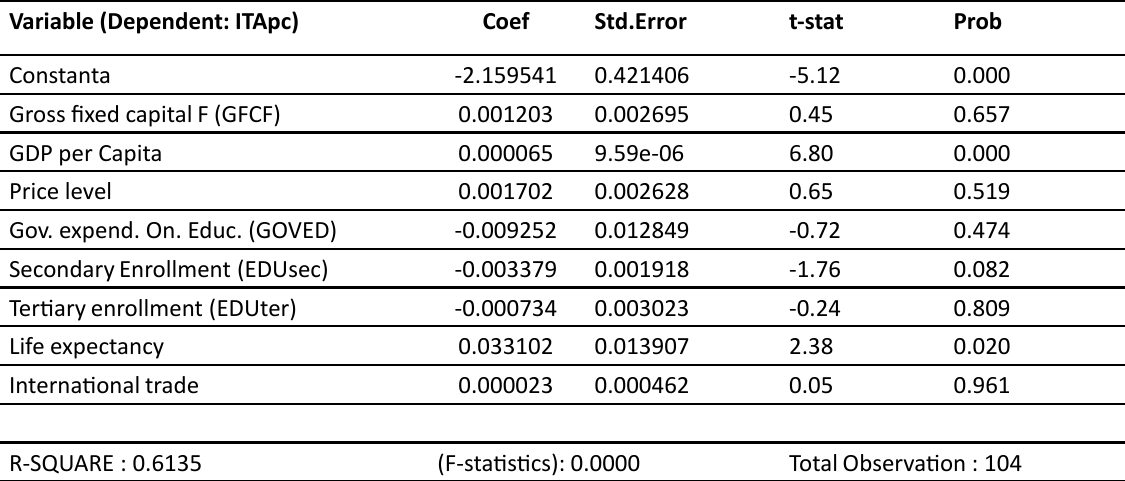
Table 3: Estimates of Fixed Effect Model (FEM) with the Weighted Method and Within Group Estimator Model 1